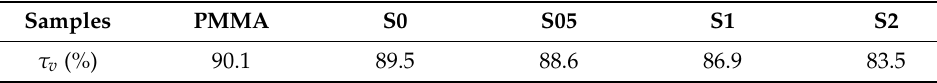
Figure 6. Visible light transmission spectra of PMMA and nano SiO 2 particles modified coatings. Table 3. Visible light transmittance of PMMA and coatings .